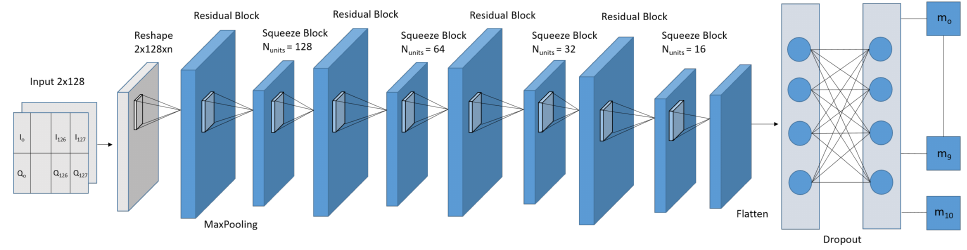
Figure 4. Overall